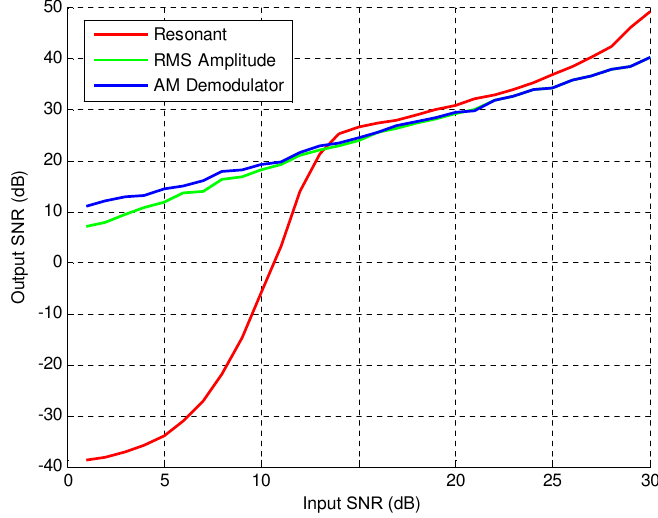
Figure 18. Average output Signal-to-Noise Ratio (SNR) for resonant and amplitude